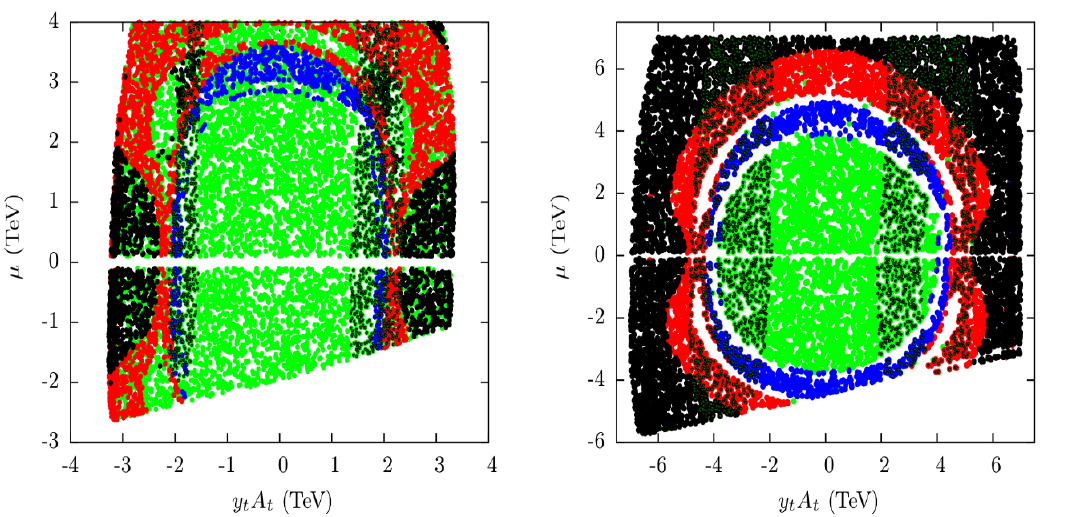
Figure 2 . Stability status of the DSB vacuum in the presence of a deeper CC vacuum along with an unavoidable deeper CCB vacuum for the cases presented in the left panel ( SPheno-Vevacious analyses) of (cid:12)gure 1. The left (right) plot corresponds to the top left (bottom left) plot of (cid:12)gure 1. The color code adopted is as follows: green stands for a stable DSB vacuum (global minimum), blue represents a metastable but cosmologically long-lived DSB vacuum, black indicates the presence of a DSB vacuum which is unstable under quantum tunneling at zero temperature while red corresponds to a DSB vacuum unstable against tunneling when the (cid:12)nite temperature corrections to the potential are included. The vertical bands in dark-green again delineate the regions compatible with the observed SM-like Higgs